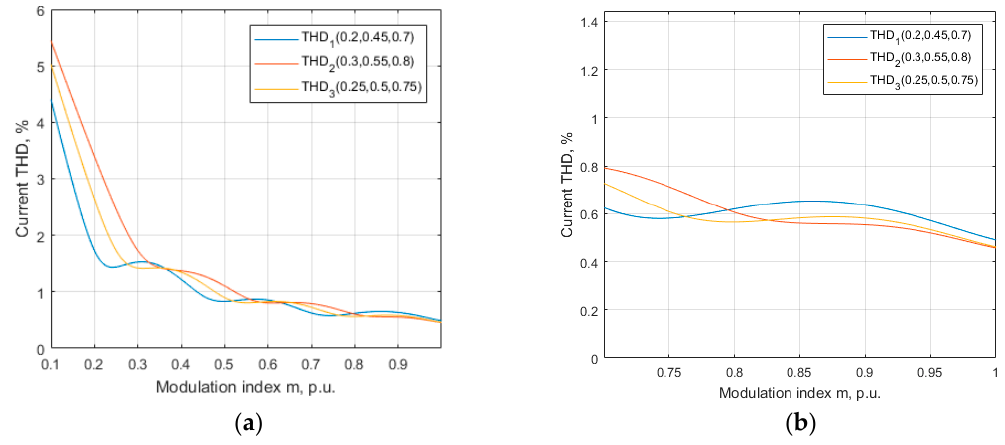
Figure 3. Total harmonic distortion (THD) for LS PWM: ( a ) 0.1 < m < 1; ( b ) 0.7 < m < 1.